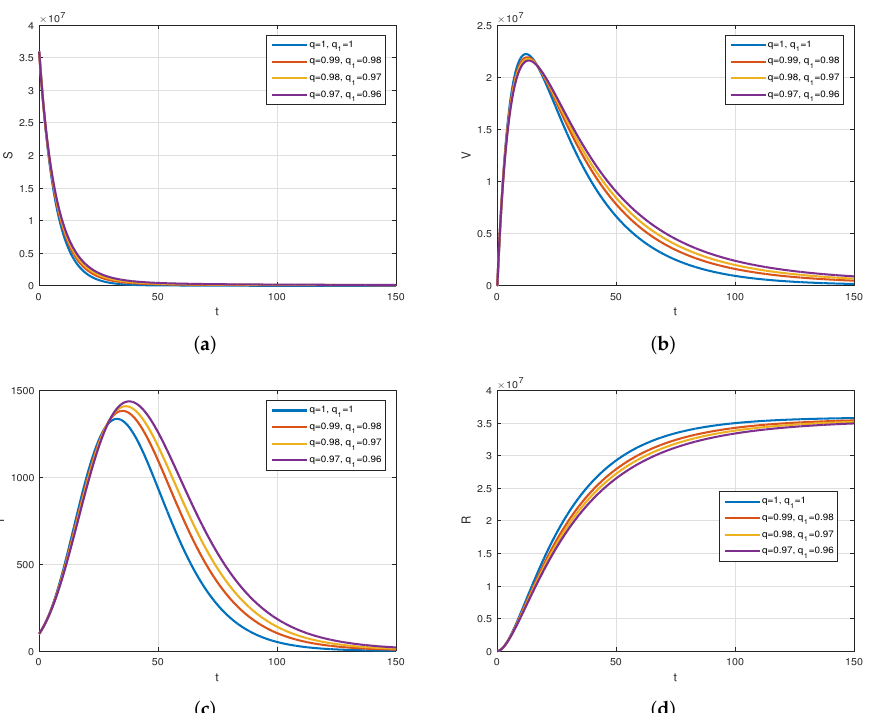
Figure 5. The plot displays the behavior of the model for various values of q and q 1 . Subfigure ( a ) shows the simulation of healthy population for various values of q and q 1 . Subfigure ( b ) shows the simulation of vaccinated population for various values of q and q 1 . Subfigure ( c ) shows the simulation of infected population for various values of q and q 1 . Subfigure ( d ) shows the simulation of recovered population for various values of q and q 1